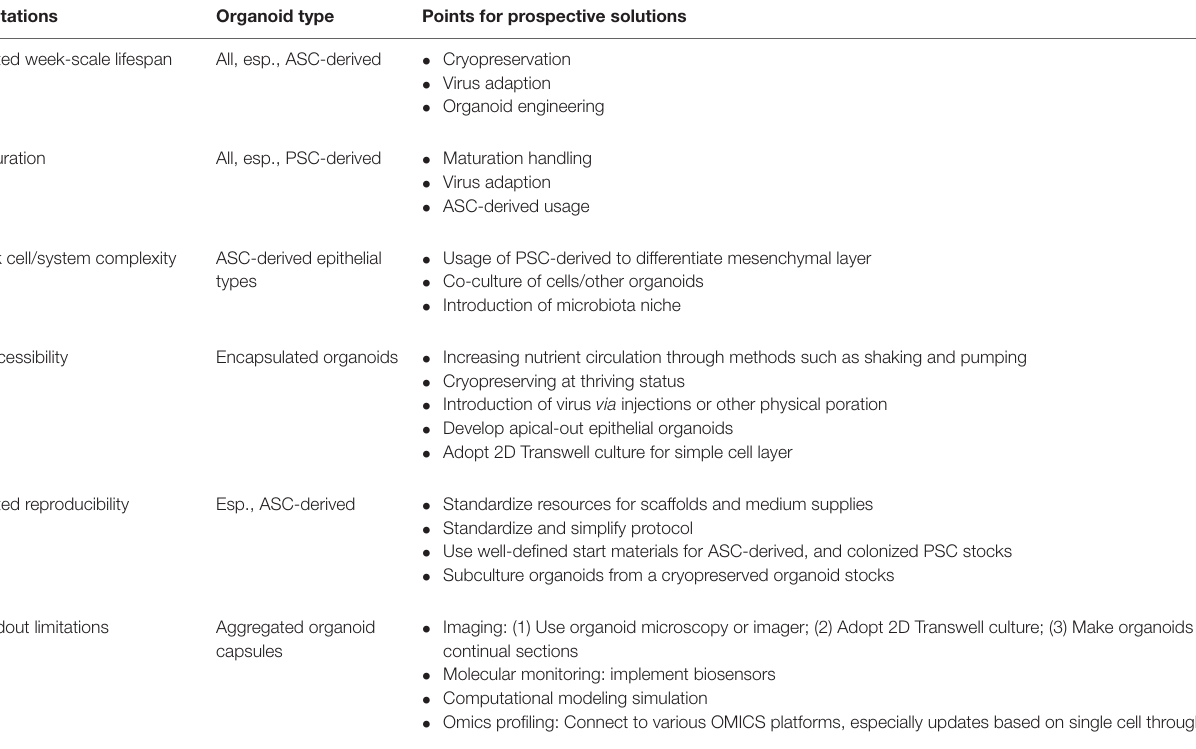
TABLE 3 | Limitations of current organoid systems and potential solutions for virus research (Shanks et al., 2009; Lehmann et al., 2019; Kim et al., 2020; Hofer and Lutolf,